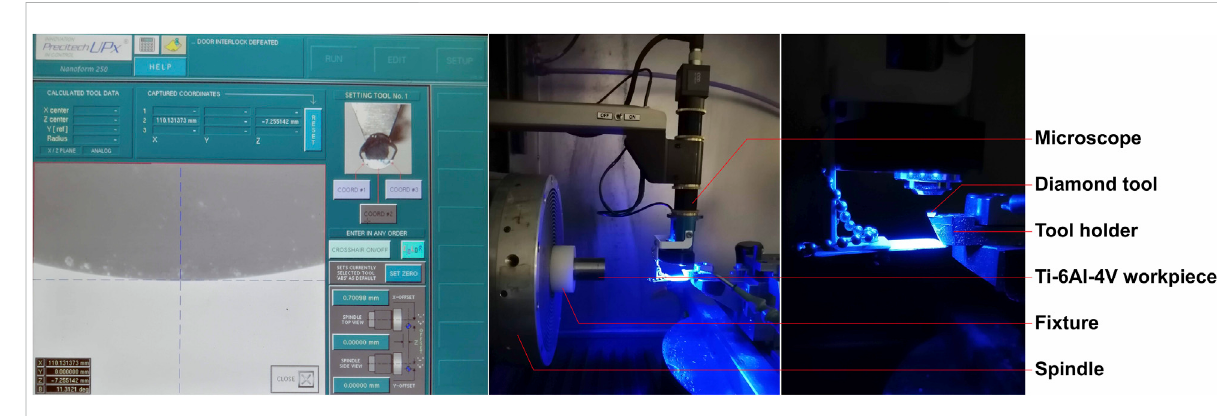
FIGURE 4 Installation of the diamond tool on the machine tool and on-machine setting of the rake